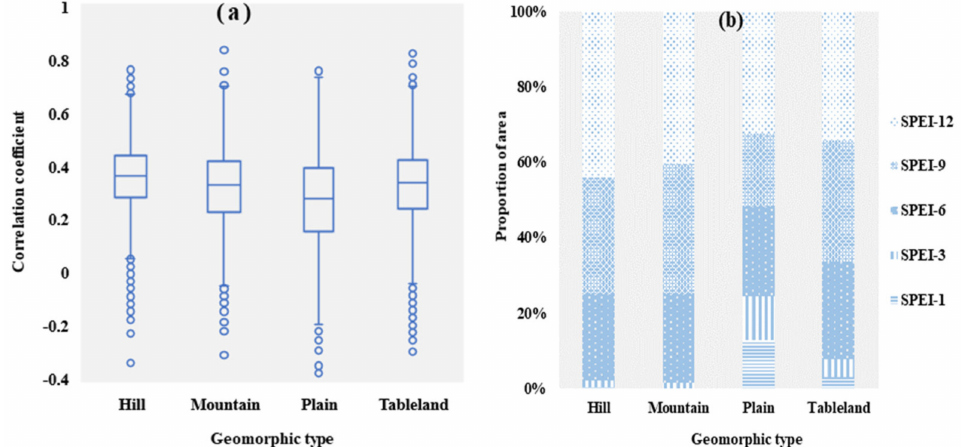
Figure 6. The maximum correlation coefficient of different geomorphic types: ( a ) Box − and − whisker plots (25th to 75th percentiles at the ends of the box. Median is indicated with a horizontal line in the interior of the box. Maximum and minimum values are at the ends of the whiskers); ( b ) Proportions with the maximum correlation at different time scales by geomorphic